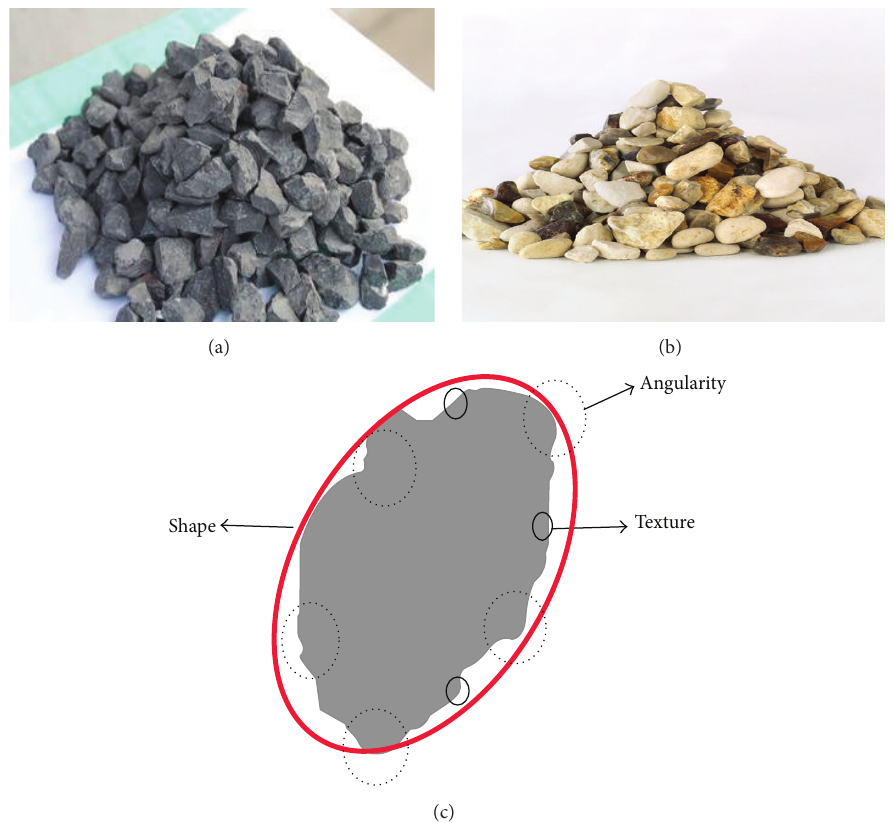
Figure 1: Illustration of morphological characteristic of aggregates: (a) angular aggregates; (b) subround aggregates; (c) shape characteriza-